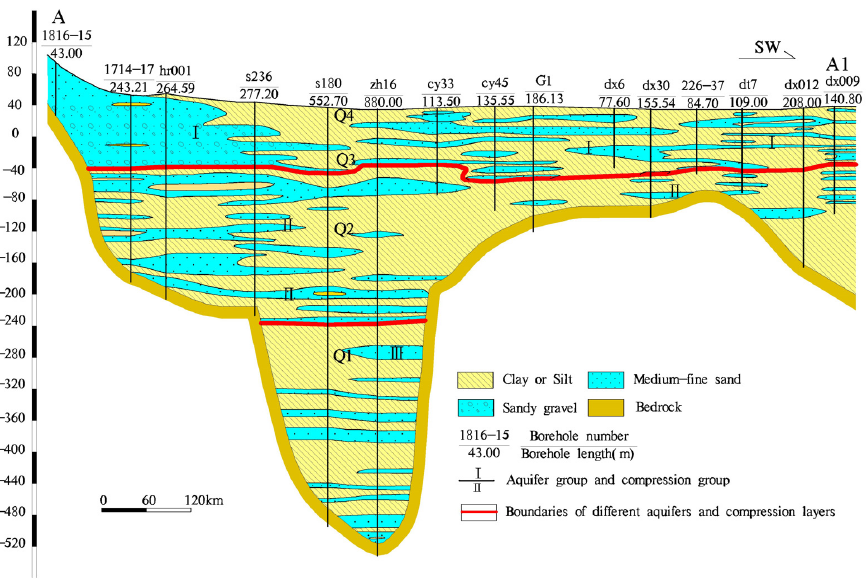
Figure 2. Hydrogeologic cross-section of Beijing alluvial-proluvial fan along the north to south A–A1 (the location is shown in Figure 1).